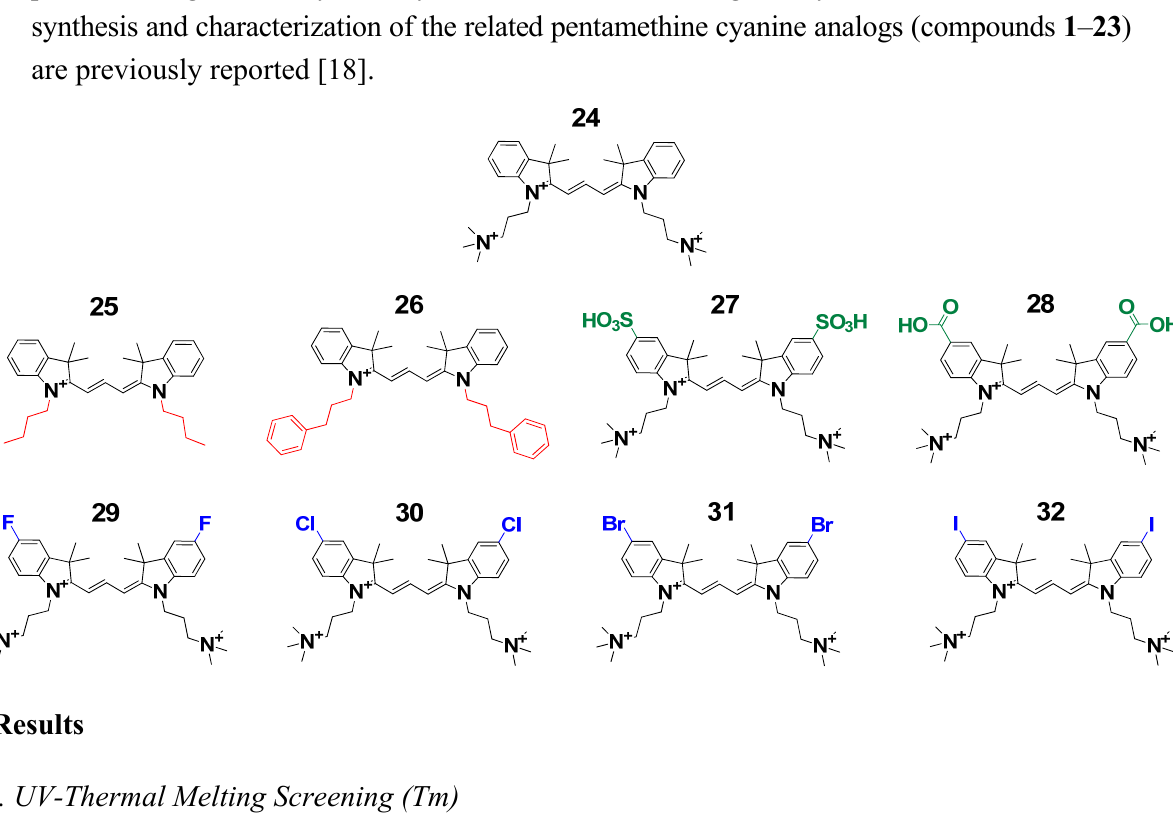
Figure 1. Trimethine cyanine analogs used in the current study. The modifications performed on the parent cyanine ( 24 ) are highlighted in different colors (compounds 25 – 32